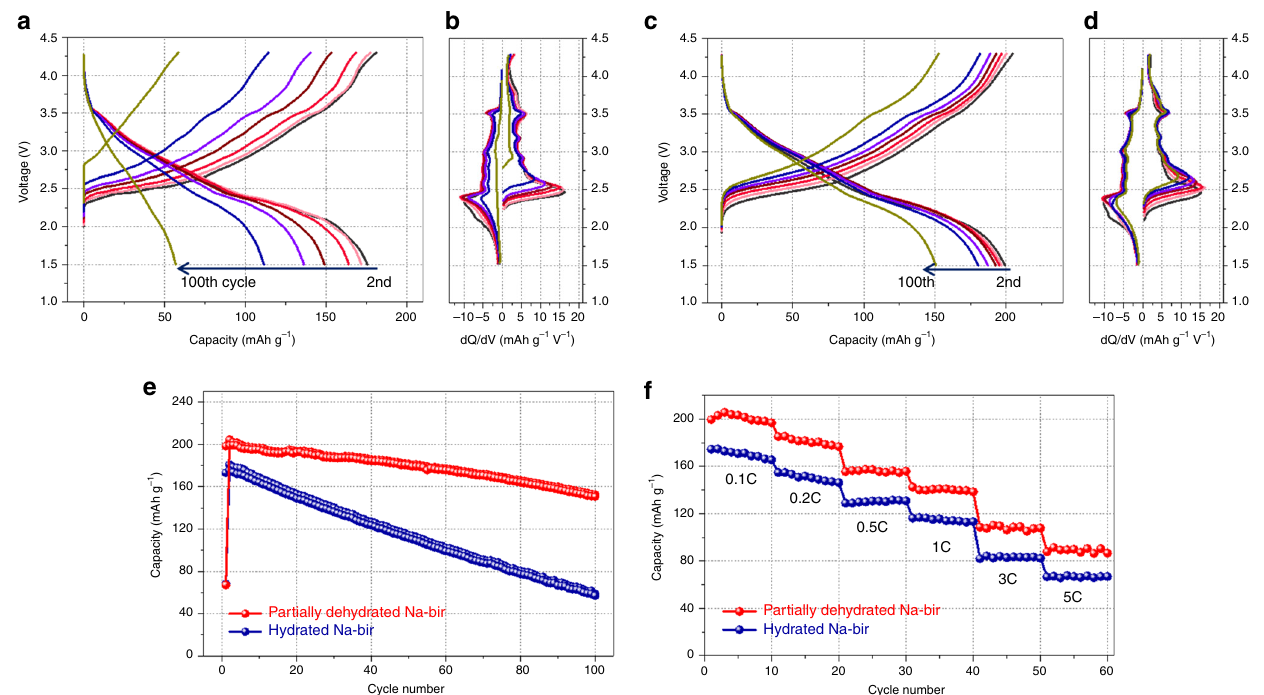
Fig. 2 Electrochemical performances of hydrated and partially dehydrated Na-birs. Charge/discharge pro fi les and the differential capacity vs. voltage plots (d Q /d V ) of a , b hydrated and c , d partially dehydrated Na-bir at the 2nd, 5th, 10th, 20th, 30th, 50th, and 100th cycle. e Cyclic retention at 0.1 C and f discharge capacities of hydrated and partially dehydrated Na-bir at various rates from 0.1 to 5